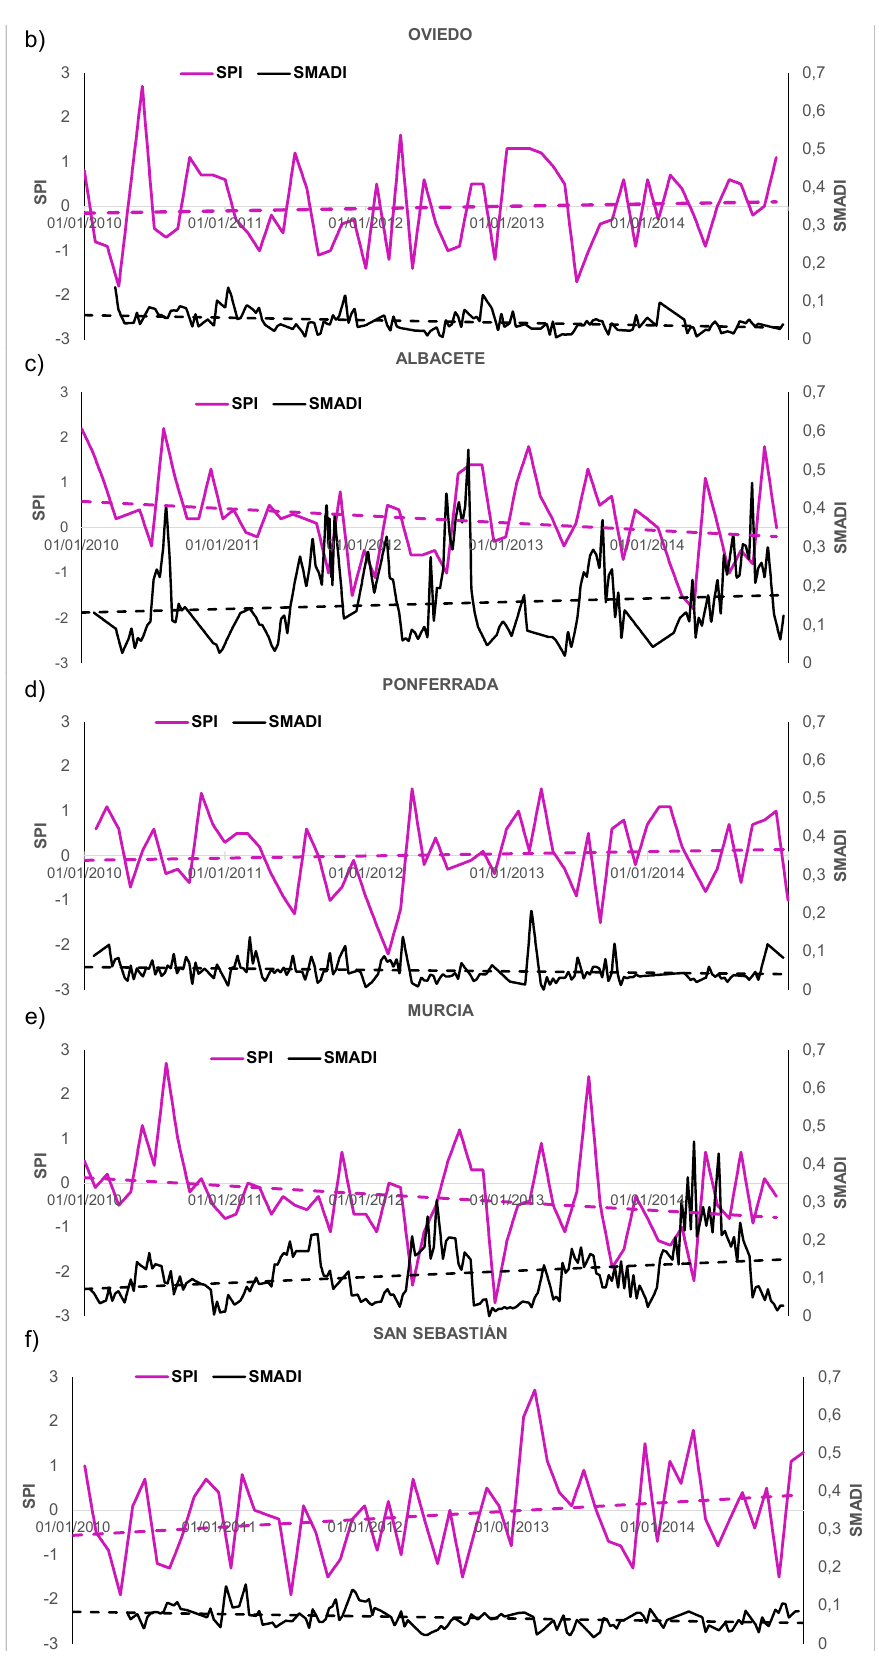
Figure 8. ( a – f ) Temporal evolution of SMADI and SPI at three dry ( a , c , e ) and wet ( b , d , f ) locations. Only the NDVI-LST day version was